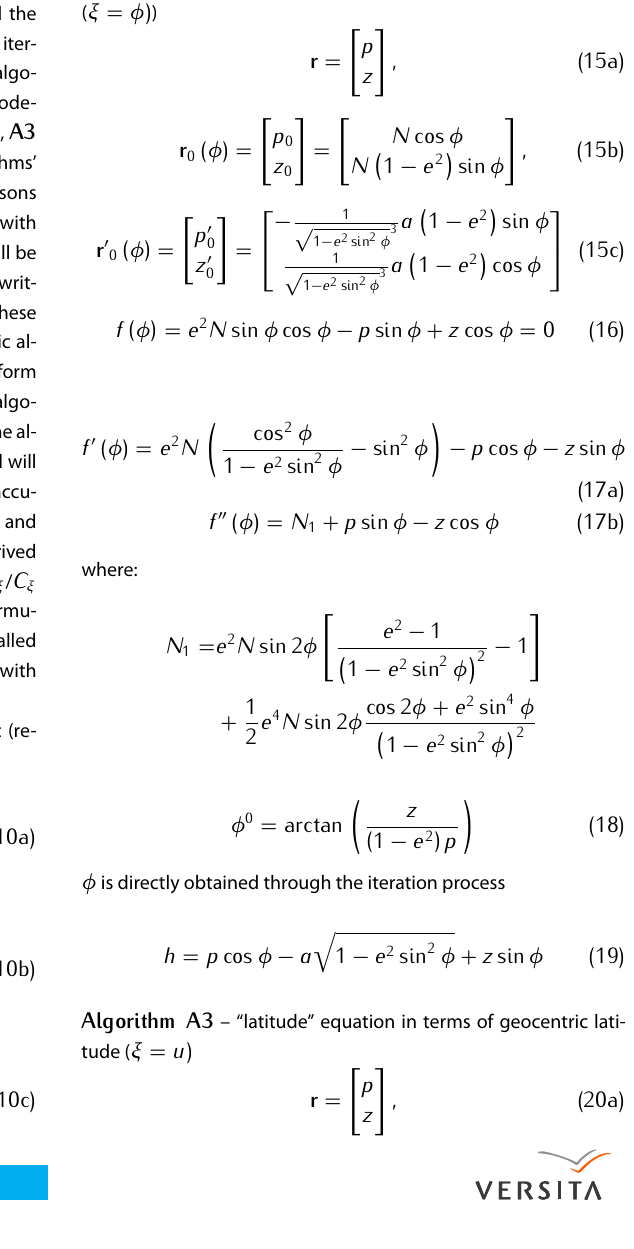
Algorithm A2 – “latitude” equation in terms of geodetic latitude